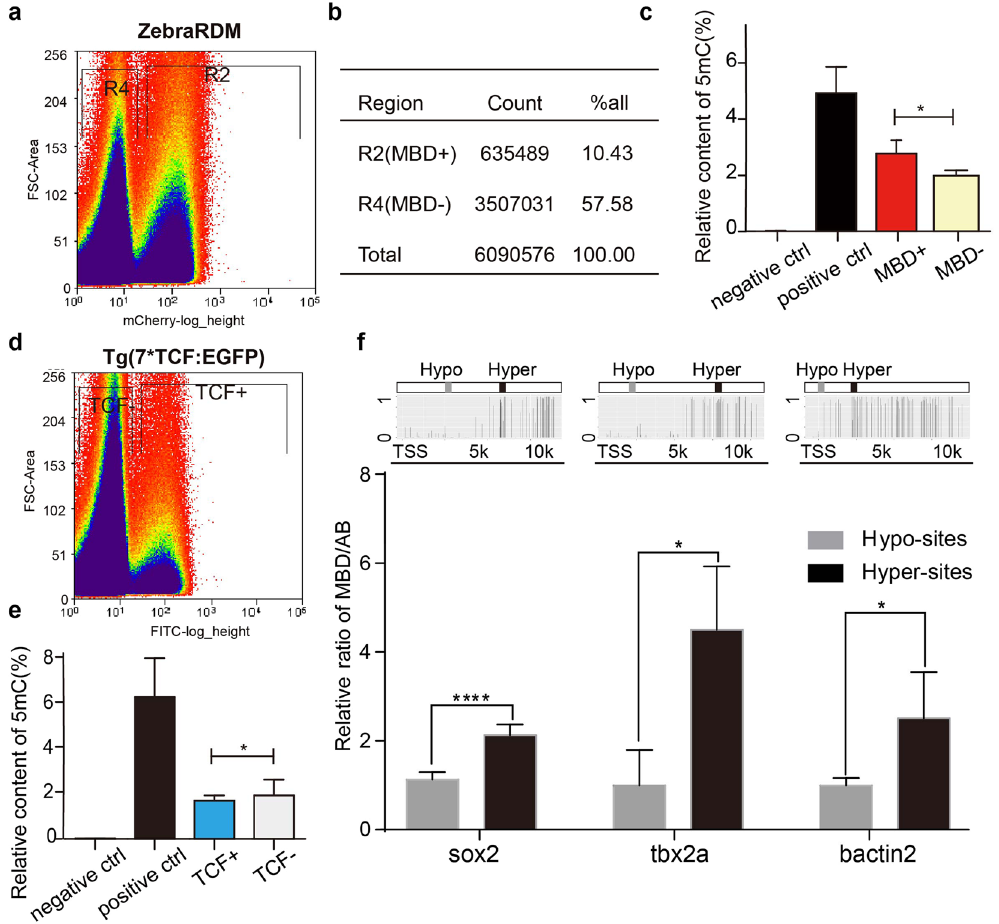
Figure 4. Differential methylated cells and gene loci recognized by the probe mCherry-MBD. ( a ) The mCherry fluorescence dot plot of cells in zebraRDM. R2, MBD + group; R4, MBD − group. ( b ) Cell numbers and proportion of sorted cells. ( c ) Columns represent the percentage of 5 mC in DNA isolated from the MBD + and MBD − groups (P = 0.026). ( d ) The GFP fluorescence dot plot of Wnt-responsive cells. ( e ) Columns represent the percentage of 5 mC in DNA isolated from TCF + and TCF − groups (P = 0.0489). ( f ) The Chip-qPCR results of three genes ′ hypo-/hyper-methylated sites. The images above are schematic pictures of three genes’ methylation status and their hypo-/hyper-methylated sites’ position. Columns represent the content of specific sites’ DNA fragment, normalized to the AB control. TSS, transcription start site; Hypo-sites, hypo-methylated sites; Hyper-sites, hyper-methylated